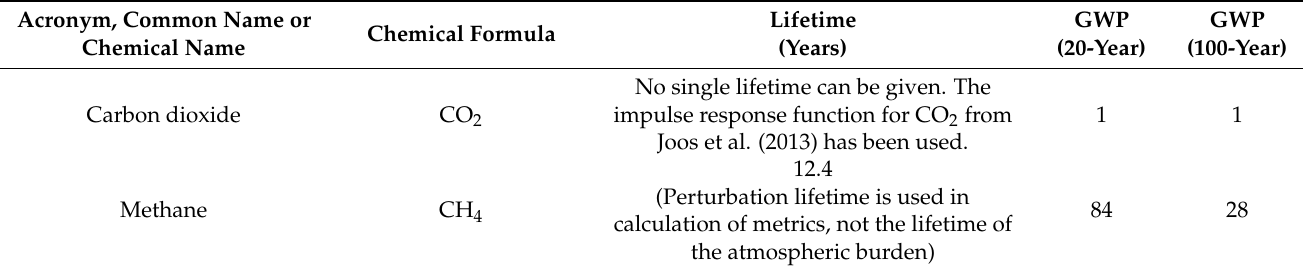
Table 5. The GWP (Global Warming Potential) of methane